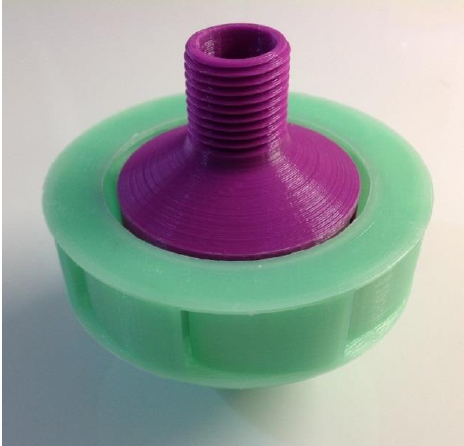
Figure 4. Turbine micromodel according to RF patent No. 203,833 (variant). Source: authors’ development.